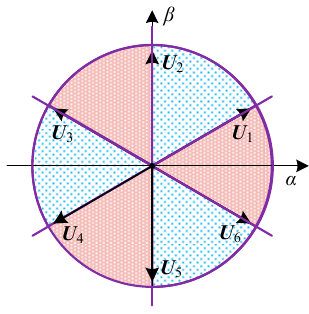
Figure 4. Vector space division for reactive power.